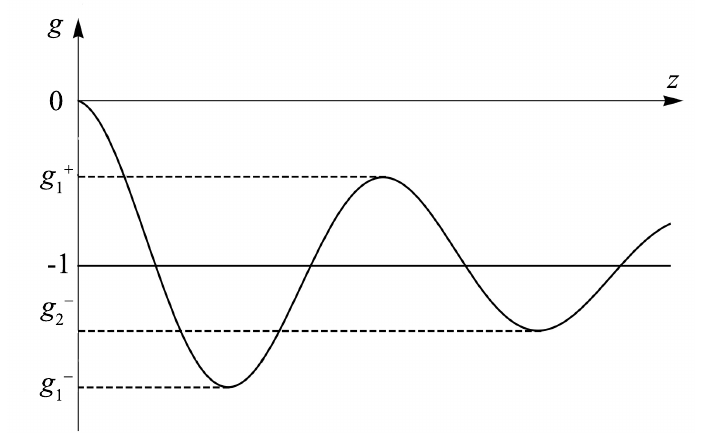
Figure 1. Plot g ( z )